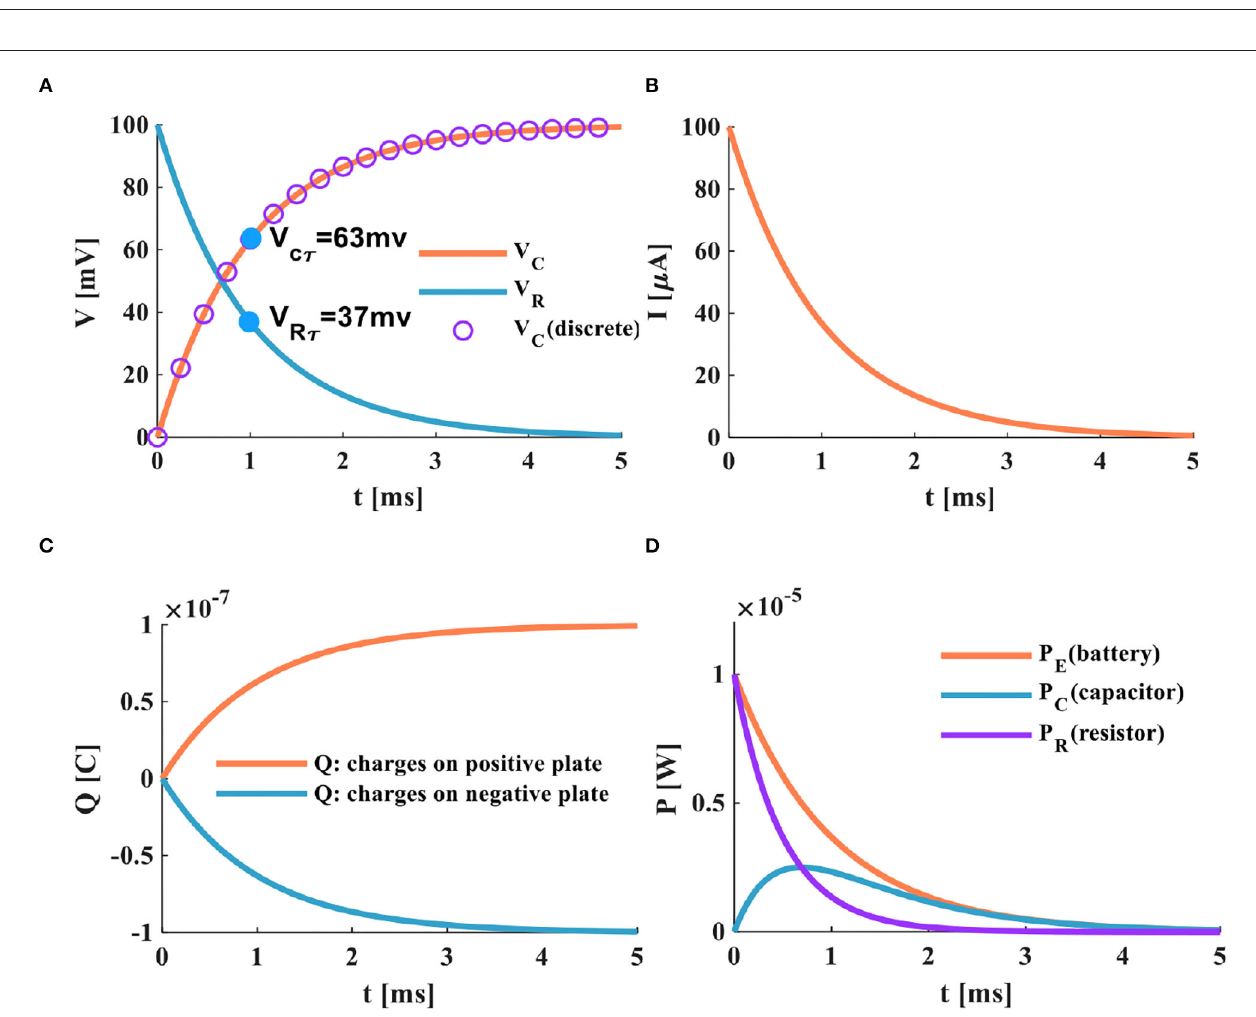
FIGURE 3 | The charging process of the RC neuron circuit, (A) the charging process of the capacitor, (B) the charging current of the RC neuron circuit, (C) the changing of charges on positive and negative plates of the membrane capacitor, (D) the power variation of the RC neuron circuit.